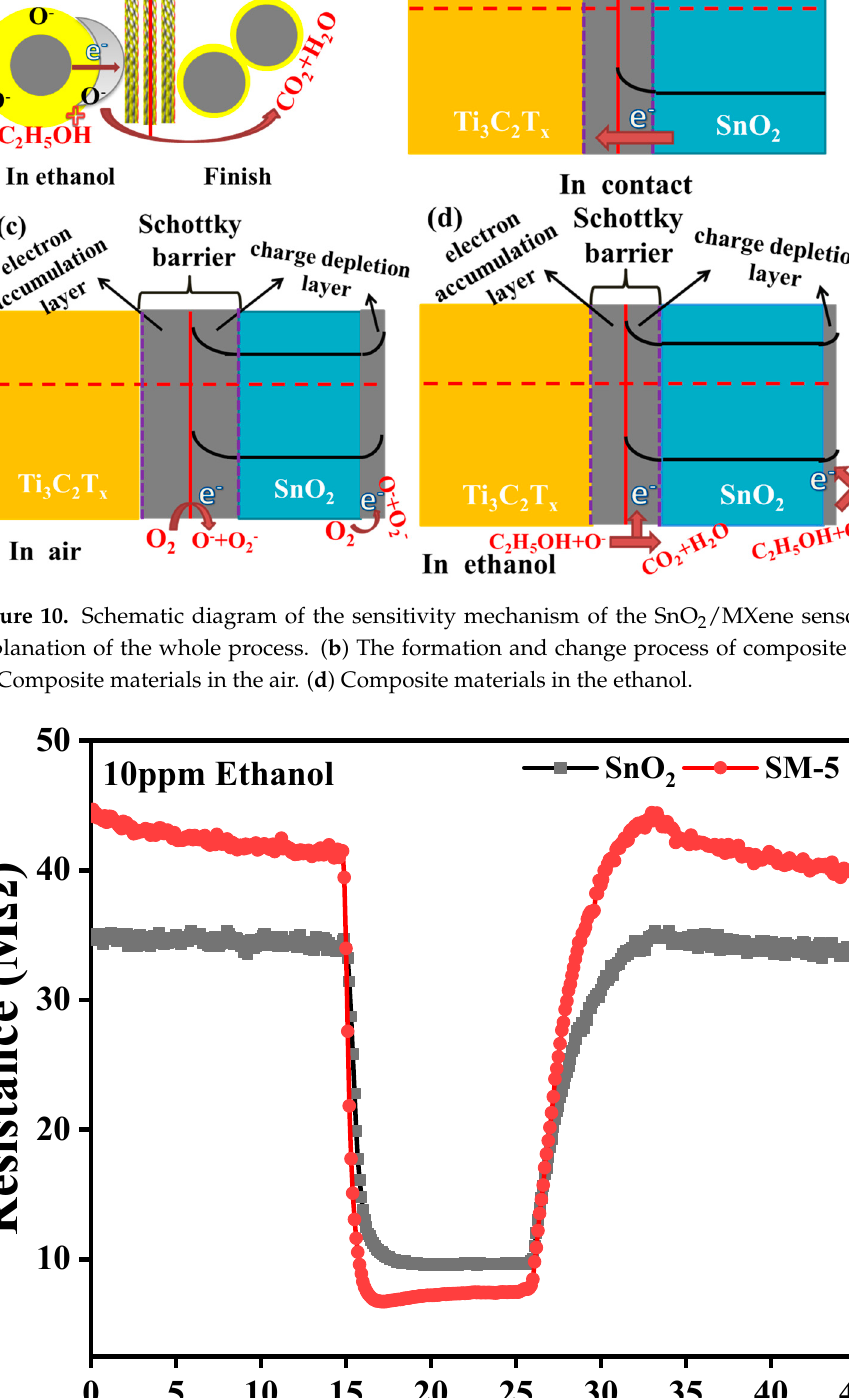
Figure 11. Schematic diagram of the sensitivity mechanism of the SnO 2 /MXene sensor.